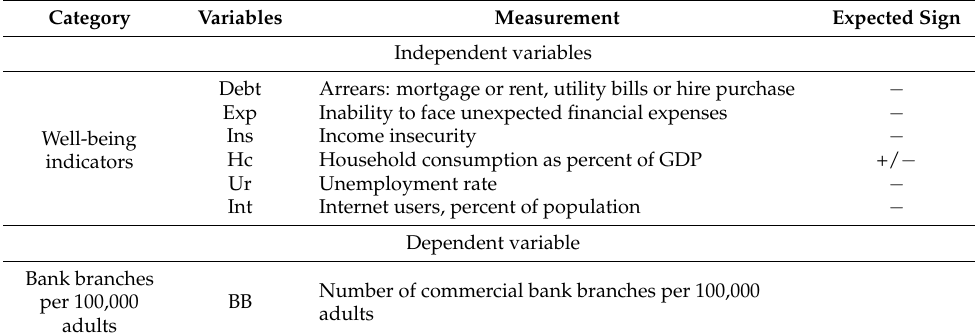
Table 1. Variables description.